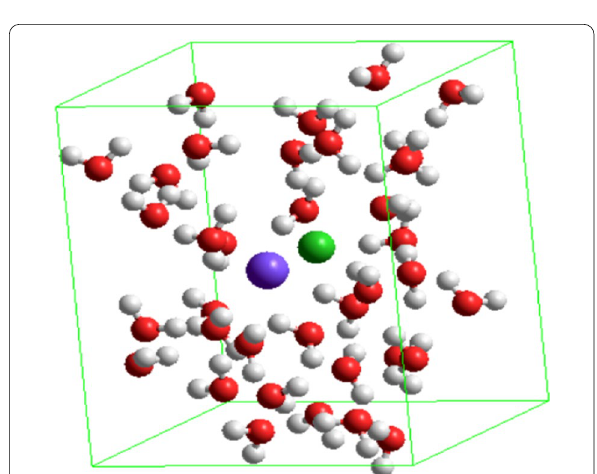
Fig. 14 A cubic simulation box of water–NaCl, where Cl − ion is violet, Na + ion is green, oxygen is red, and hydrogen is white